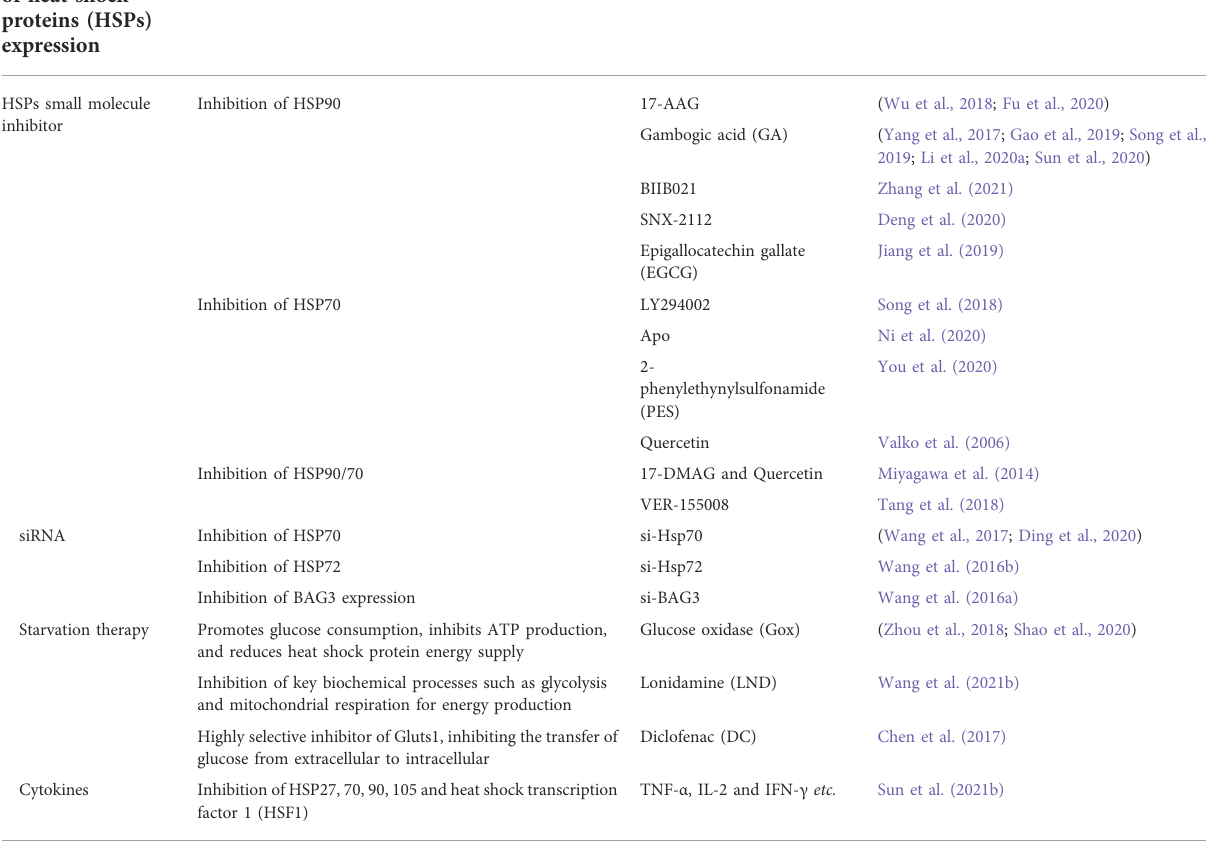
TABLE 1 The summary of different inhibitory modes for HSPs in low temperature